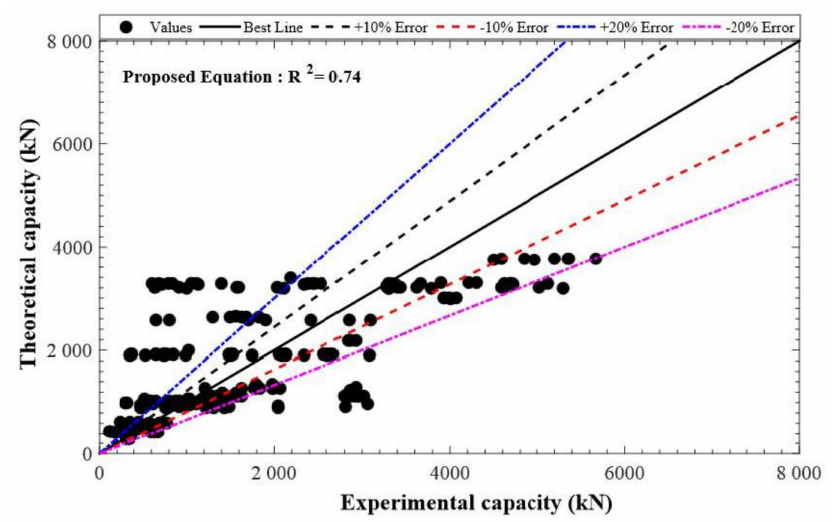
Figure 10. Performance of the newly suggested